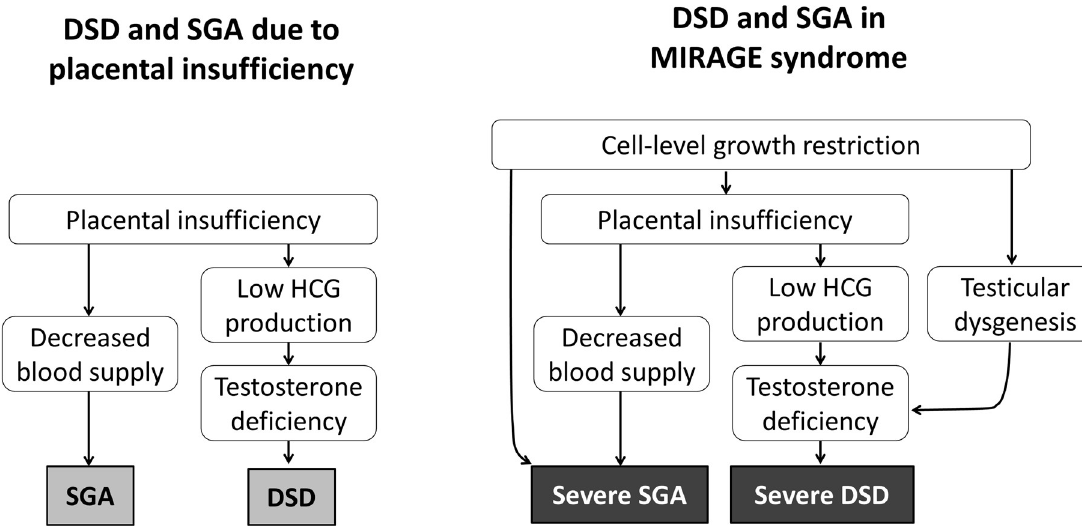
Fig 5. Schematic diagrams showing the mechanism of SGA and DSD in simple placental insufficiency and MIRAGE syndrome. SGA and DSD can be resulted from placental insufficiency ( Left panel ). In MIRAGE syndrome, cell-level growth restriction, which is a direct effect of a SAMD9 variant, cause additional negative effect on fetal growth and testicular development, giving rise to more severe phenotype than simple placental insufficiency.